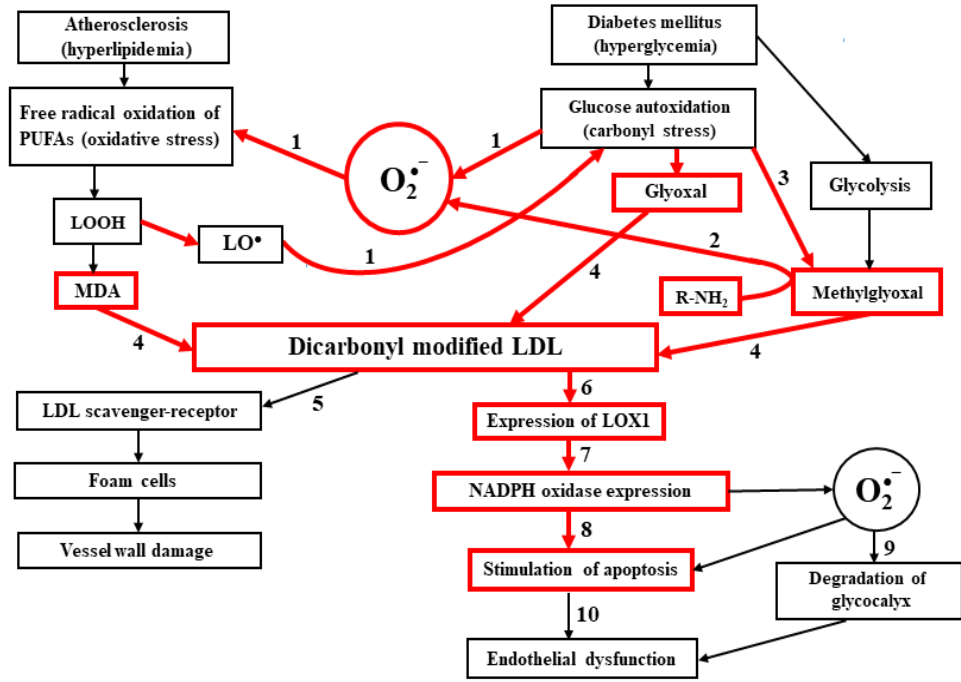
Figure 1. The main stages of atherogenic damage of the vascular wall during oxidative and carbonyl stress in atherogenesis and diabetogenesis and the development of endothelial dysfunction under the action of dicarbonyl-modified LDL (based on literature and own data). Red lines and rectangles highlight the metabolic reactions and processes whose existence was experimentally confirmed by the authors of this review. Numbers denote: 1. Pathways of secondary development of oxidative stress in diabetes associated with increased free-radical lipoperoxidation in atherogenesis [42,44]; 2. An alternative pathway of oxidative stress development in diabetes associated with the formation of superoxide anion radical and other ROS during the reaction of amino-containing compounds with methylglyoxal (Maillard reaction) [43]; 3. Non-enzymatic formation of methylglyoxal when glucose derivatives are attacked by alkoxyl lipid radicals [43]; 4. Chemical modification of LDL, involving various natural dicarbonyls: MDA, glyoxal, and methylglyoxal [11,24,27,38]; 5. Foam cell formation and preaterosclerotic (lipoidosis) damage of the vascular wall under the action of dicarbonyl-modified LDL [11]; 6. Expression of LOX-1 on endotheliocyte membranes under the action of dicarbonyl-modified LDL [54]; 7. Expression of NADPH-oxidase in endotheliocytes during the accumulation of dicarbonyl-modified LDL and under generation of superoxide anion radical by this enzyme system [54]; 8. Stimulation of endotheliocyte apoptosis by superoxide anion radical and other ROS generated by NADPH-oxidase [50–53]; 9. Glycocalyx degradation under the action of superoxide anion radical and other ROS [71–75]; 10. Free-radical mechanism of endotheliocyte membrane damage and development of endothelial dysfunction